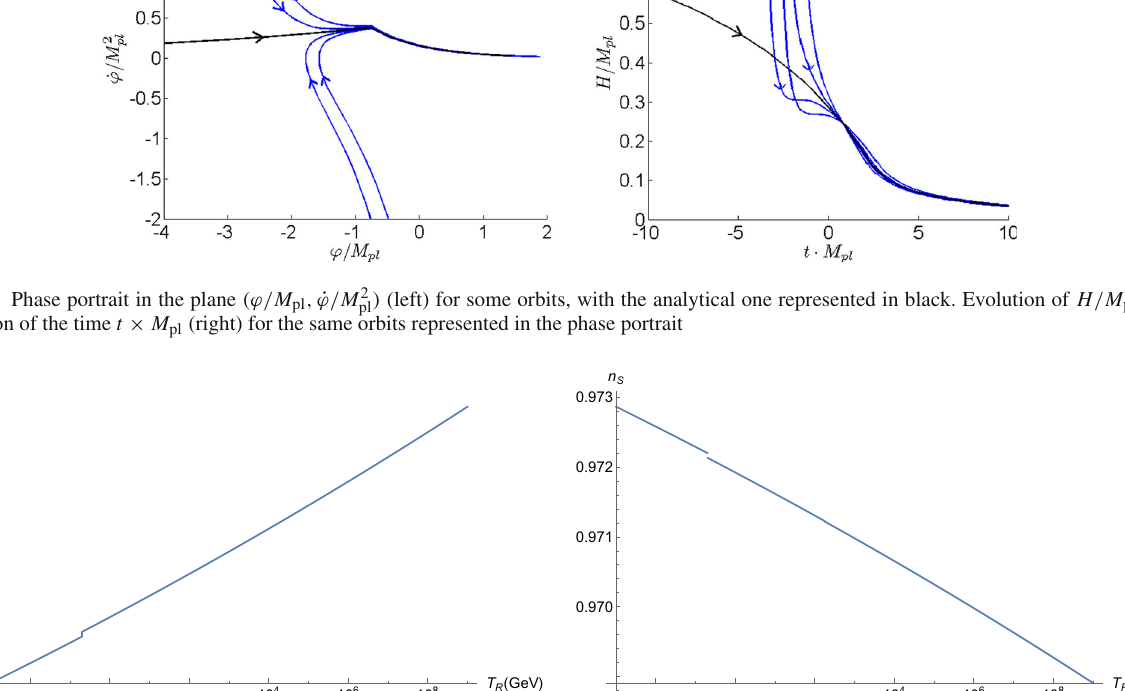
Fig. 3 Evolution of the tensor/scalar ratio r (left) and the spectral index n s (right) versus the reheating temperature T R hand, it is also fulfilled that 0